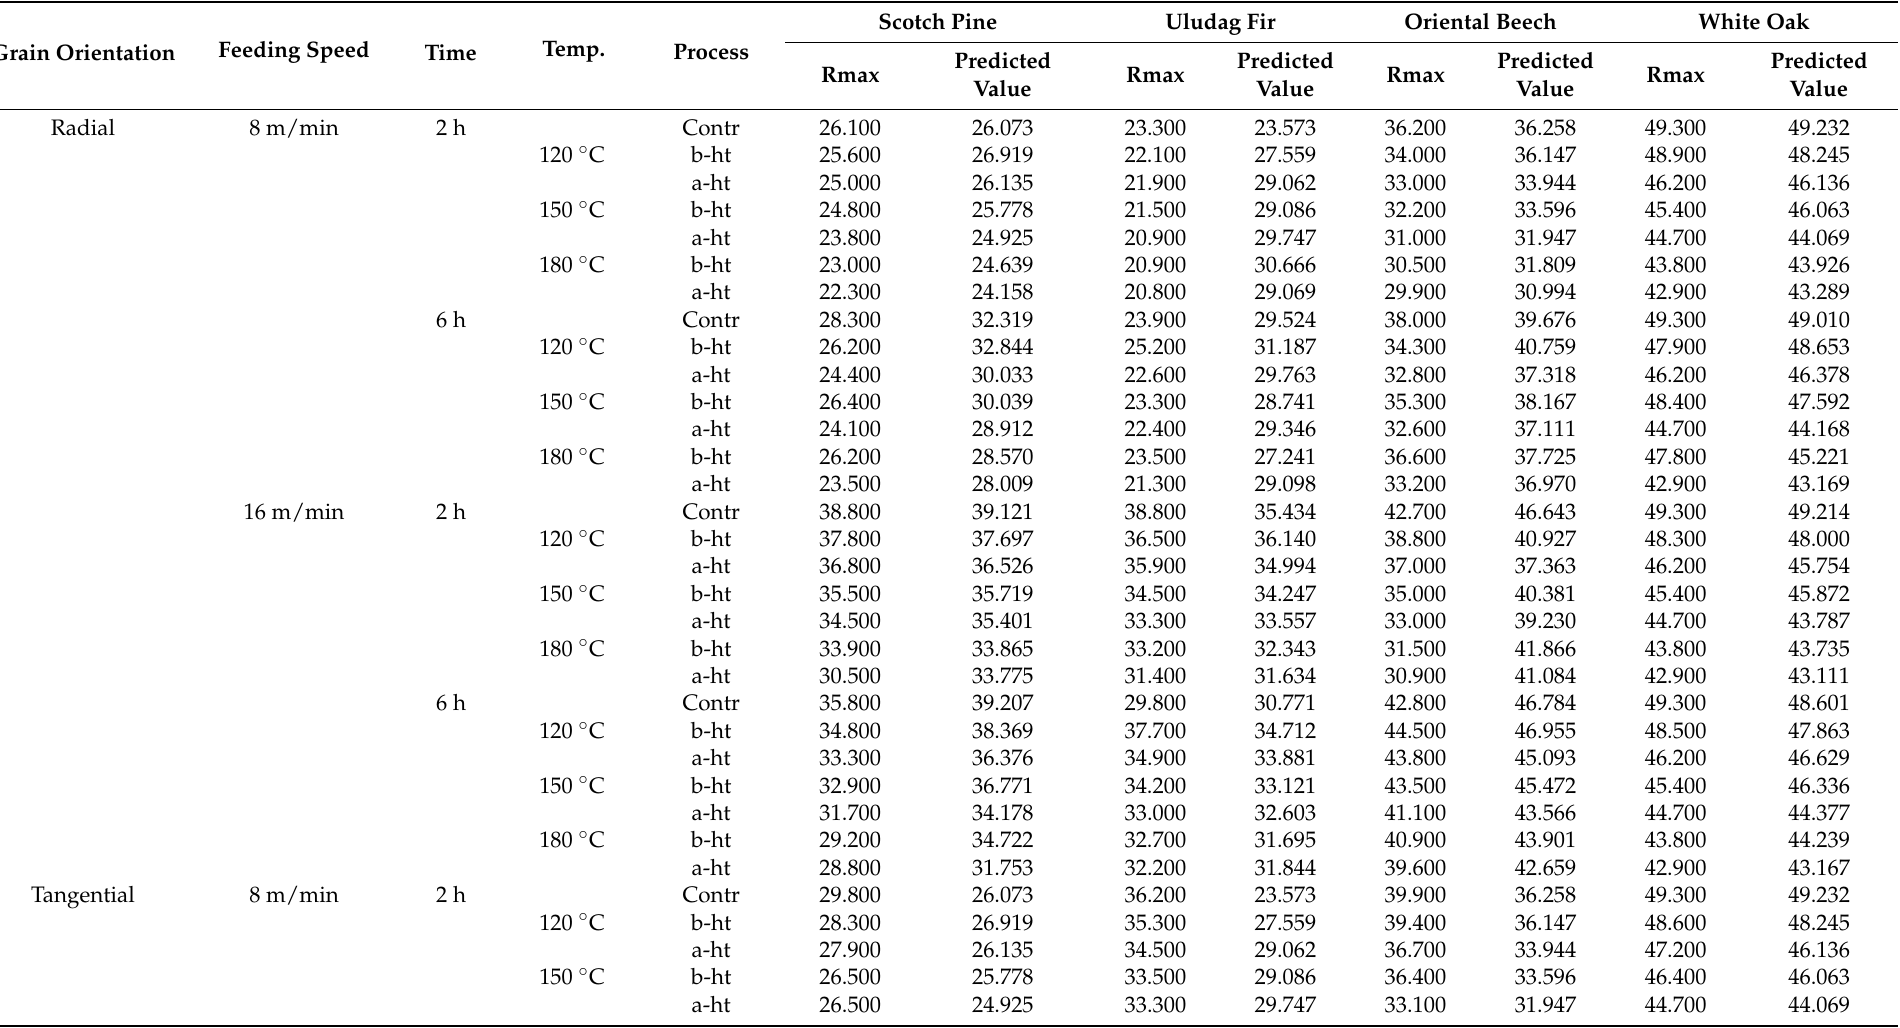
Table 7. The measured and the predicted values of surface roughness